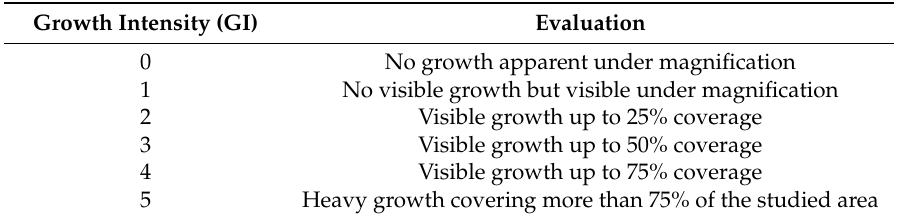
Table 3. Visual assessment of growth intensity according to ISO